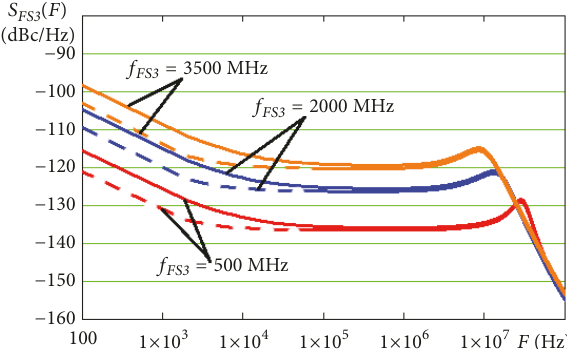
Figure 12: SPD of thephasenoises ofa hybrid frequencysynthesizer with a DDS as a support oscillator of the PLL and ACPD for output frequencies of 500 MHz ( n 1 = 1, n 2 = 6, N = 2, N 2 = 1, 𝐾 DDS = 0,25, and 𝑛 AA = 1,95), 2000 MHz ( n 1 = 1, n 2 = 6, N = 8, N 2 = 1, 𝐾 DDS = 0,25, and 𝑛 AA = 1,95), and 3500 MHz ( n 1 = 1, n 2 = 6, N = 14, N 2 = 1, 𝐾 DDS = 0,25, and 𝑛 AA =